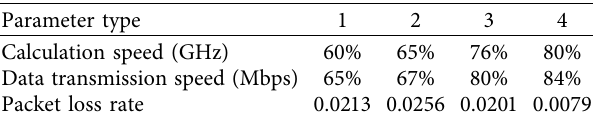
Figure 5: Mobile edge computing network. Table 1: Situation table of four-edge computing layer MEC